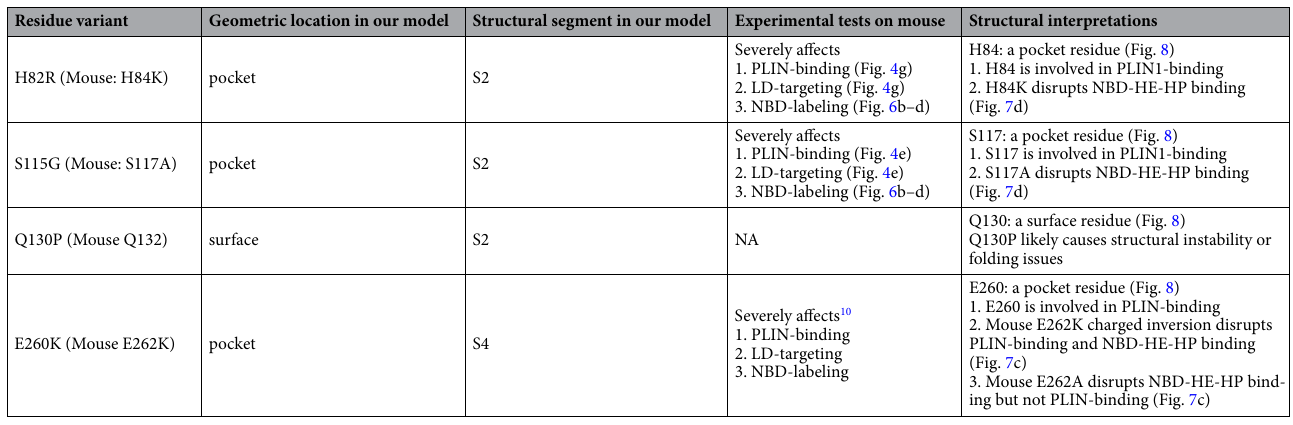
Table 1. CDS-causing non-synonymous single nucleotide polymorphisms in ABHD5.